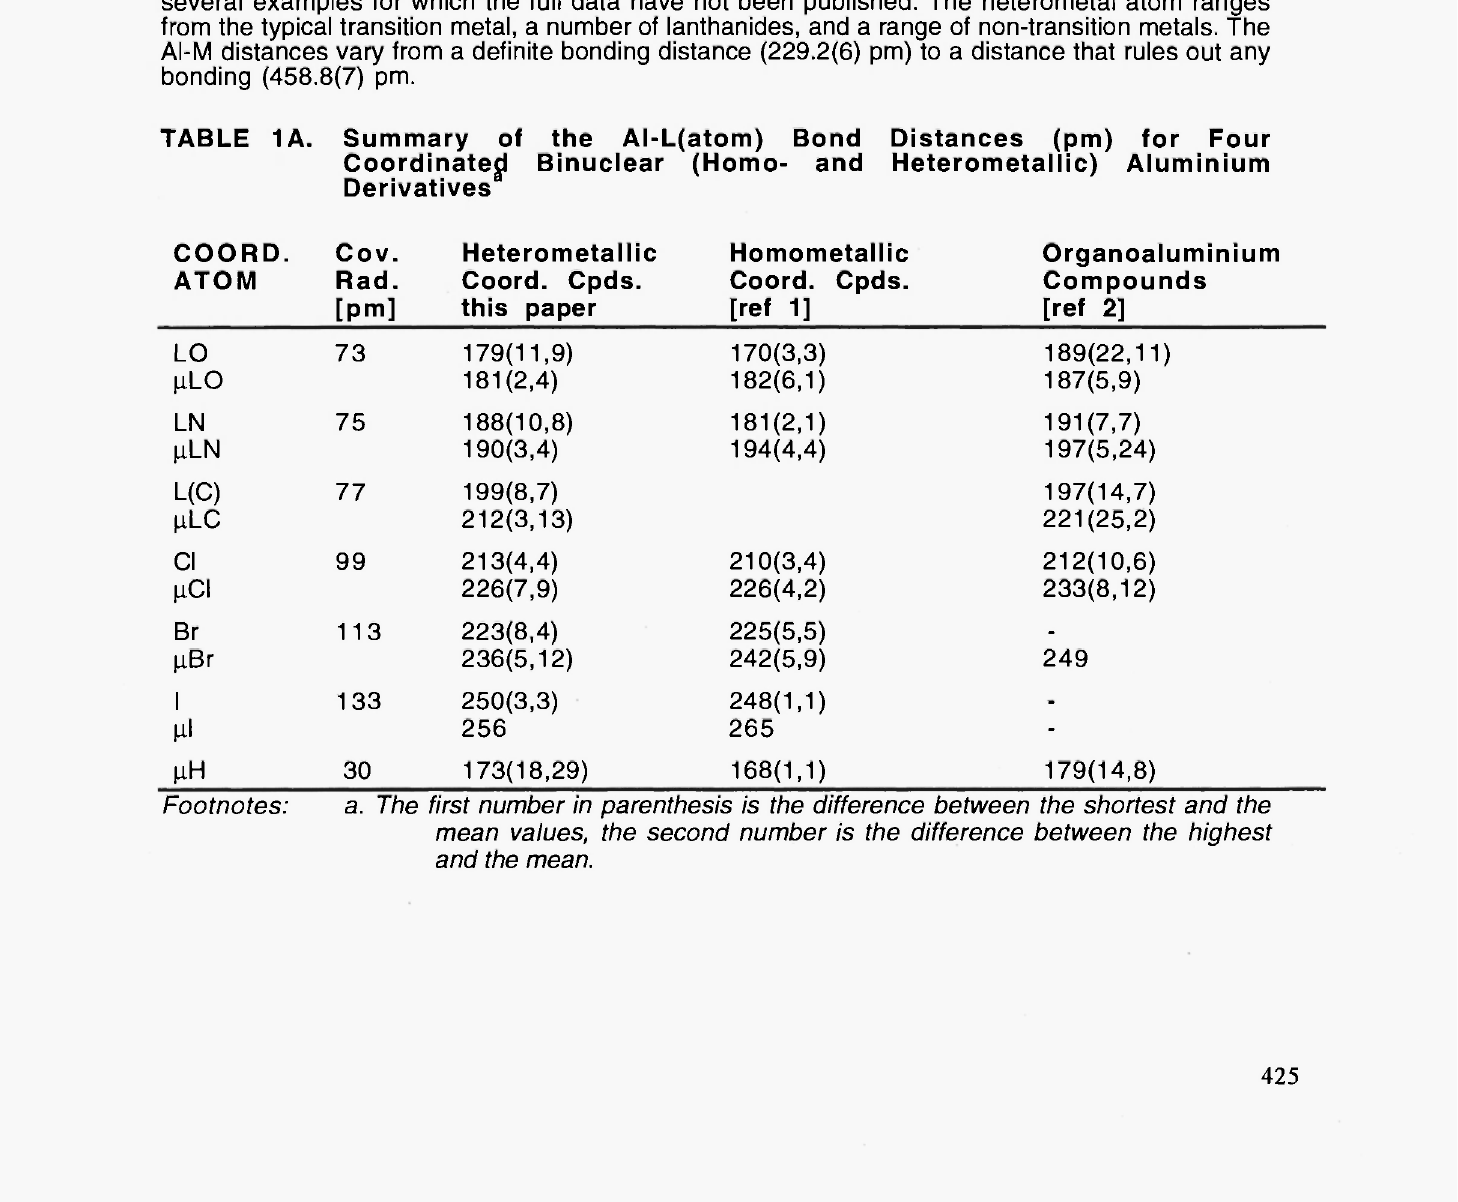
Summary of the Al-L(atom) Bond Distances (pm) for Four Coordinate^ Binuclear (Homo- and Heterometallic) Aluminium